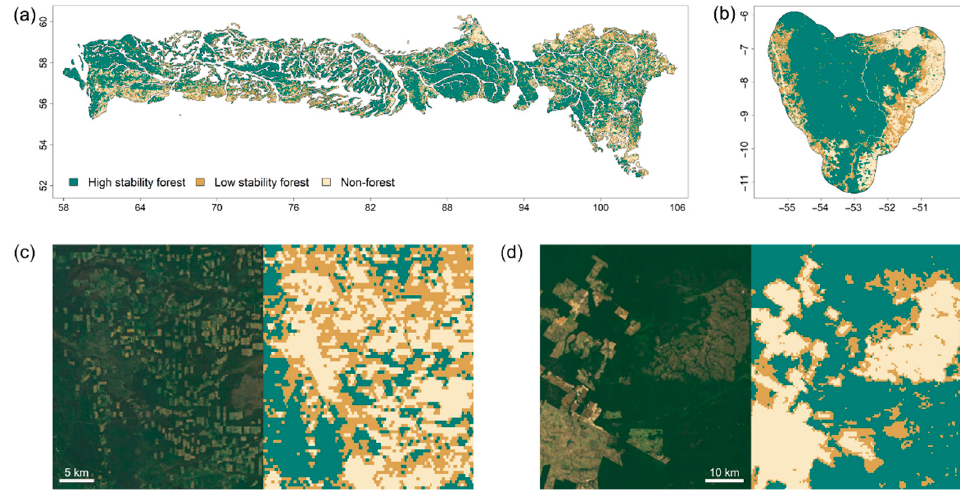
Figure 4. Mapped forest stability classes for ( a ) southern taiga ecoregion (Siberia, Russia) and ( b ) Kayapó territory (Amazon basin, Brazil). Satellite imagery exemplifying heterogeneous landscapes in ( c ) southern taiga ecoregion and ( d ) Kayapó territory in comparison with the distribution of forest stability classes as defined in this study. The imagery corresponds to true-color Sentinel-2 acquired on 31 August 2018. Stars on panels ( a , b ) depict the location of the areas shown in panels ( c , d ). Table 2. Estimated error matrix for expert validation of the resultant forest stability maps for southern taiga ecoregion (Siberia, Russia) and Kayapó territory (Amazon basin, Brazil). The validation is based on expert knowledge of the forested landscapes through the visual interpretation of changes in forest cover by using high-resolution imagery over the period 1984–2018. Forest stability classes are in rows, while the reference classes are in columns. This visual assessment was performed by using the Google Earth Timelapse app. All pixels for which expert certainty was low (<50%) were removed from the analysis. HS = high-stability forests; LS = low-stability forests; NF = non-forest areas.